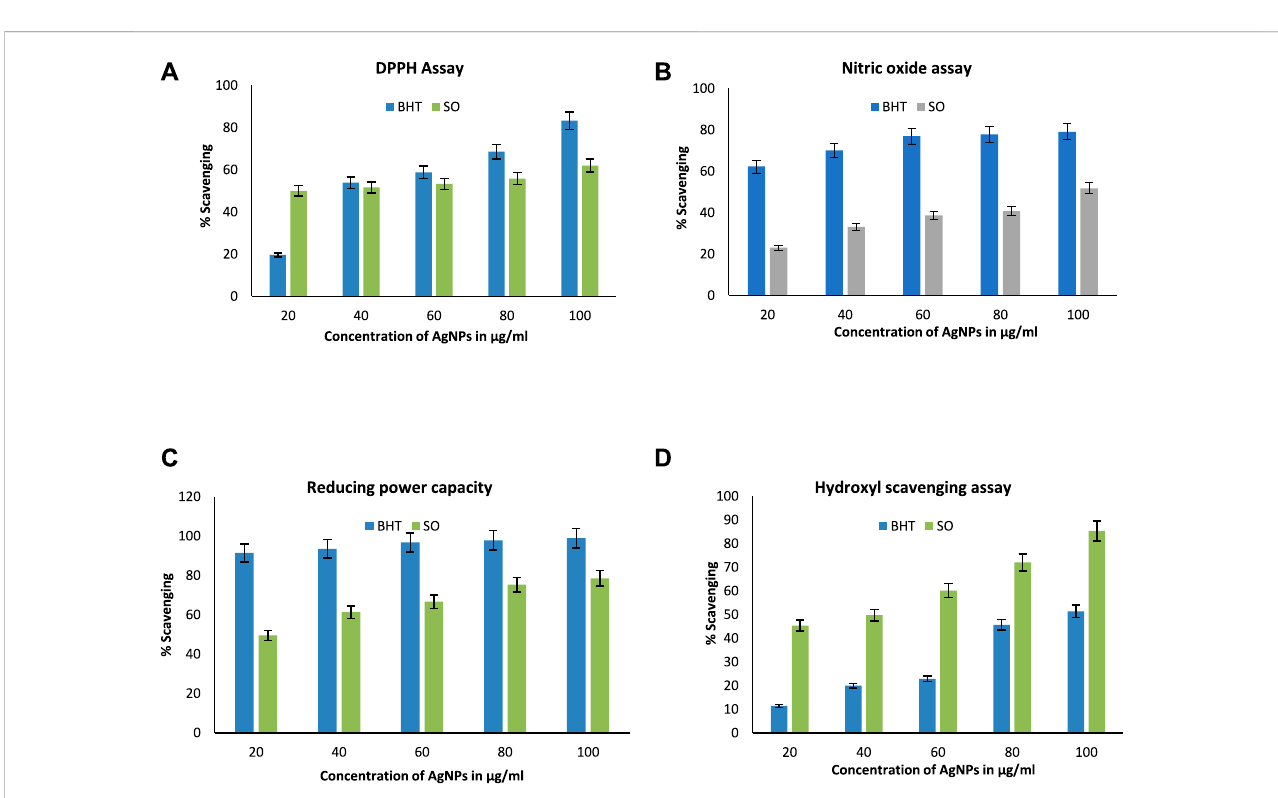
FIGURE 8 Antioxidant activity (A) DPPH radical scavenging assay; (B) nitric oxide radical scavenging assay; (C) reducing power assay, and (D) hydroxyl radical scavenging